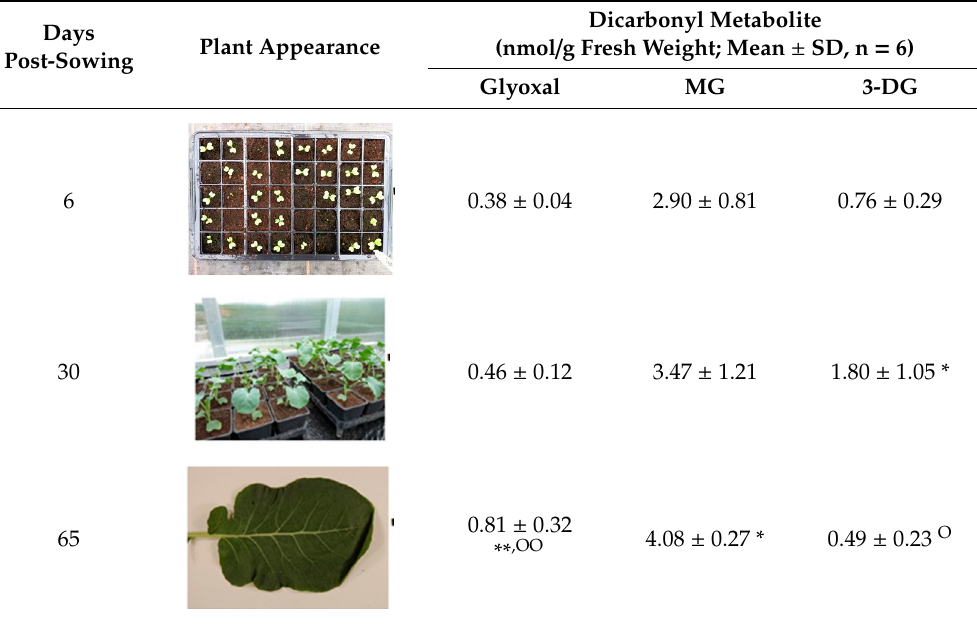
Table 3. Reactive dicarbonyl glycating agents in Brassica oleracea during development.